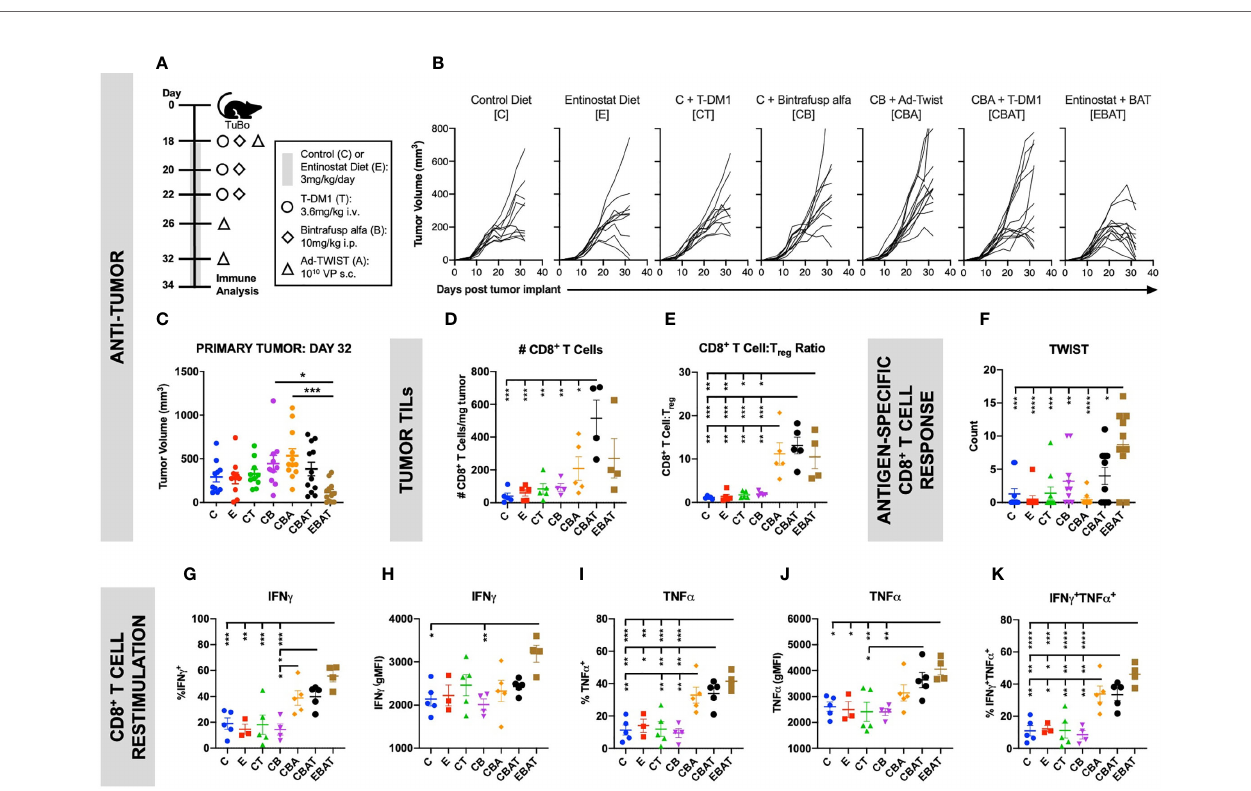
FIGURE 2 | Combination therapy resulted in improved anti-tumor immune response in an orthotopic HER2 + murine breast cancer model. TuBo breast tumor cells (4×10 5 ) were orthotopically implanted into the mammary fat pad of female Balb/c mice on day 0 and treated with either control (C) or entinostat (E) diet, T-DM1 (T), bintrafusp alfa (B), and/or Ad-Twist vaccine (A) according to the schedule and doses in (A) . (B, C) Graphs show primary tumor growth curves of individual mice in each treatment group over the entire study duration (B) , and at day 32 (C) . For (B, C) , data from 1 experiment, n=11 – 12 mice/group. (D – K) Two days after the last vaccination, tumor, and spleen immune cells were isolated. Graphs show the number of CD8 + T cells (D) , or the ratio of CD8 + T cells to T reg (E) in the tumor. (F) Splenocytes were incubated with a Twist peptide pool overnight and IFN g production was determined by ELISPOT. (G – K) Tumor CD8 + T cells were stimulated with a CD3 and a CD28 for 4 h and cytokine production was analyzed by fl ow cytometry. Graphs show frequency of total IFN g + (G) , IFN g production on a per cell basis (H) , frequency of total TNF a + (I) , TNF a production on a per cell basis (J) , and frequency of IFN g /TNF a -double producing (K) CD44 hi CD8 + T cells. For (D – K) , data from 1 experiment, n=3-5 mice/group. All graphs show mean ± SEM. Data were analyzed using one-way ANOVA with Tukey ’ s multiple comparisons. Statistical signi fi cance was set at p <0.05. *p < 0.05, **p < 0.01, ***p < 0.001, ****p <